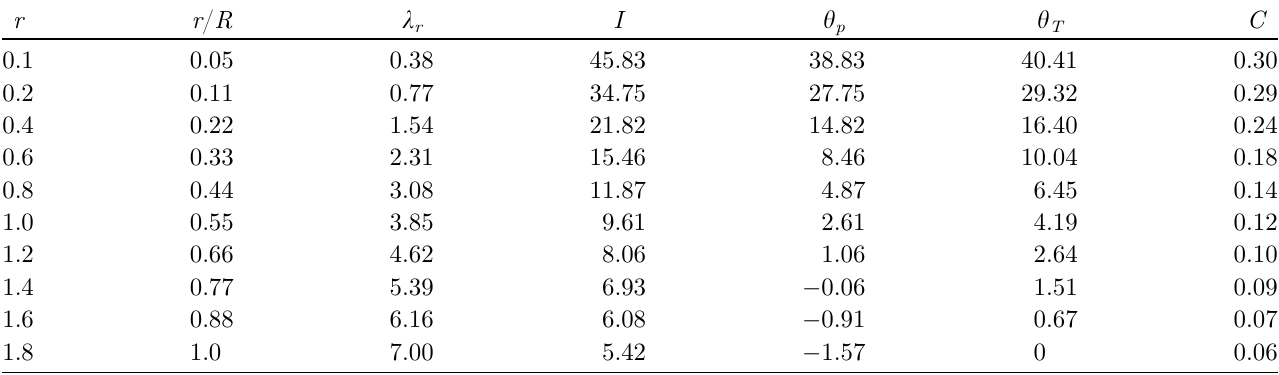
Table 2. Variation in WT-blade parameter while taking effect of wake into